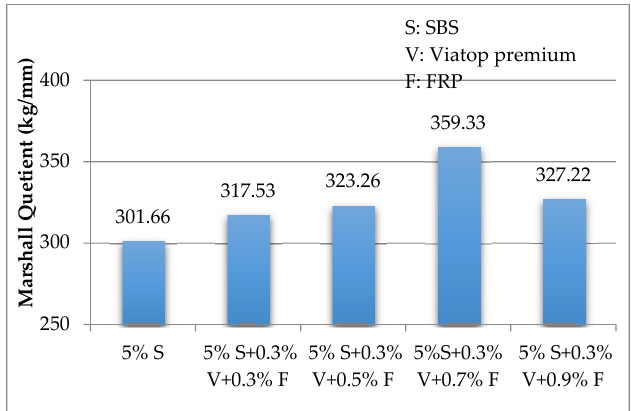
Figure 3. Results of Marshall Quotient test.